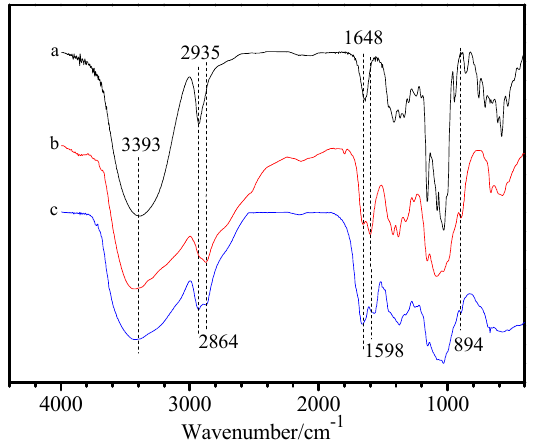
Figure 1. FTIR spectra of β -Cyclodextrin ( β -CD) ( a ); chitosan ( b ); and, CGC ( c ).